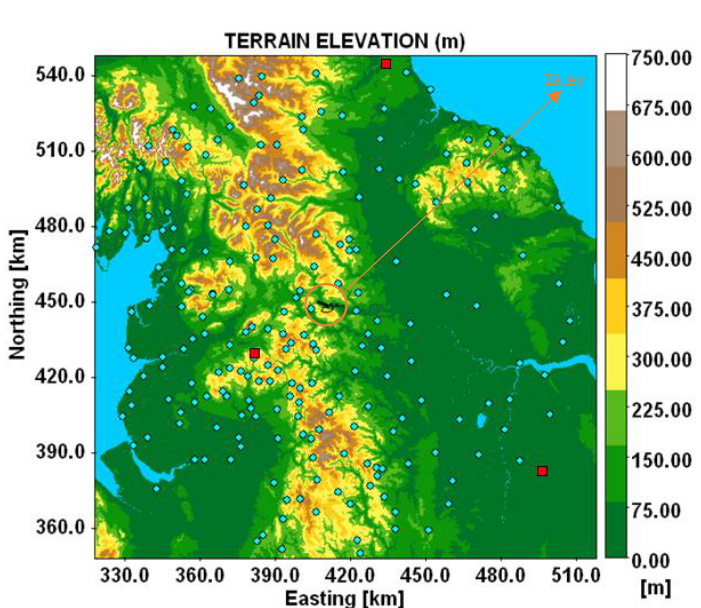
Figure 1. Location of the urban catchment (inside the orange circle), radar locations (red squares) and rain gauge positions (blue circles) in the study region.